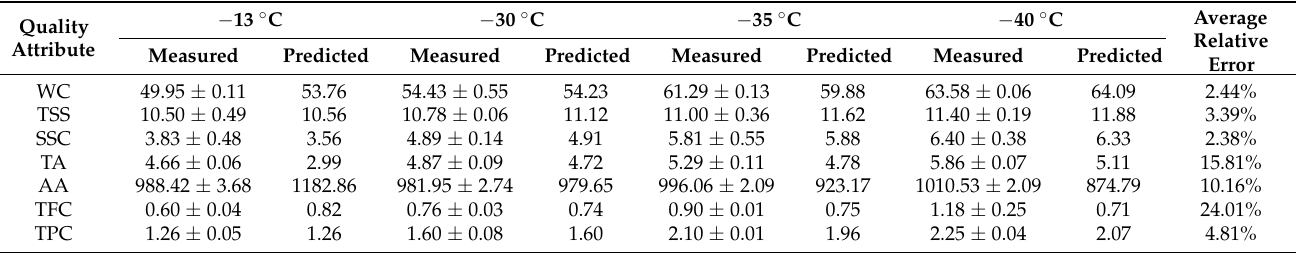
Table 3. The measured and predicted values of fruit quality attributes of verified sea buckthorn group of frozen for 90